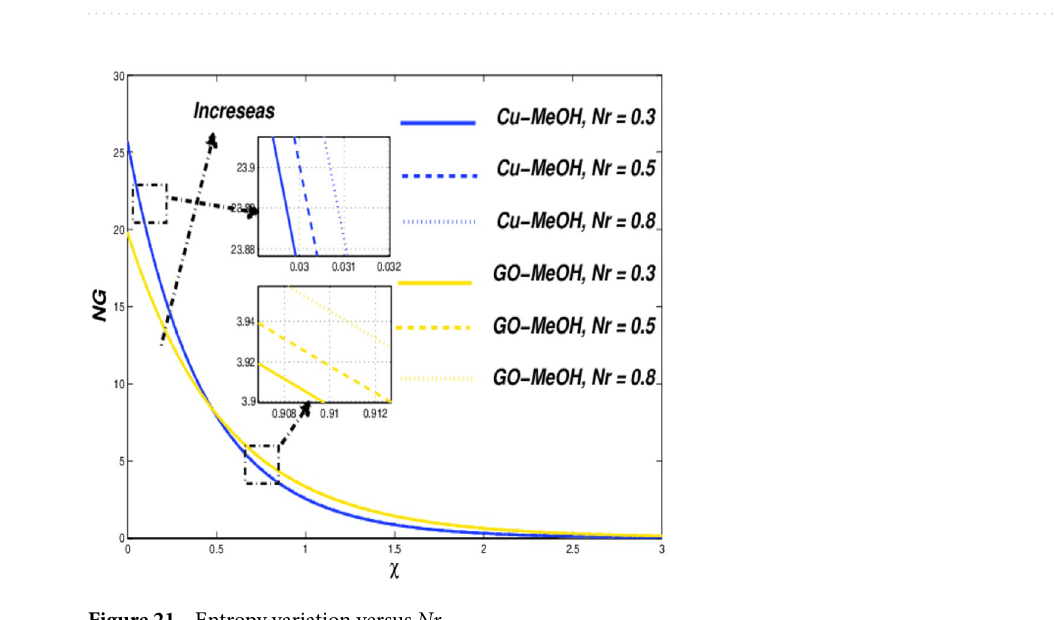
Figure 20. Temperature variation versus Nr .